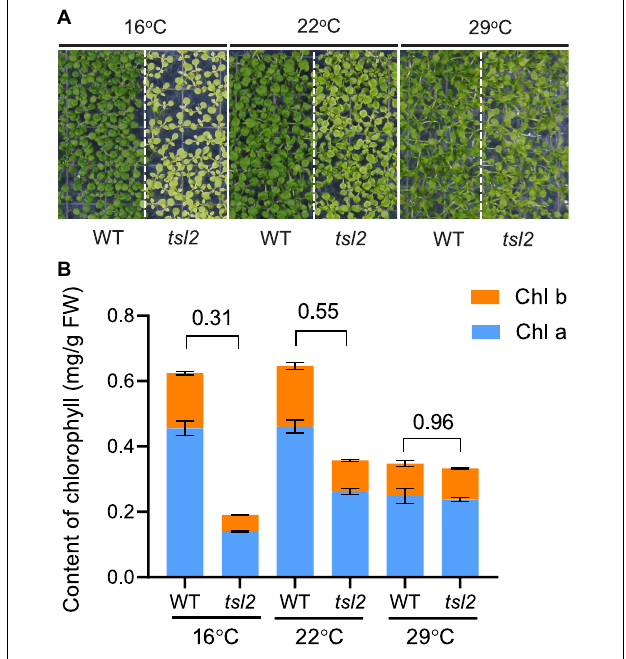
FIGURE 1 | The chloroplast development of tsl2 mutant is sensitive to cold temperatures. (A) Temperature-sensitive phenotypes of the tsl2 mutant plants. Wild-type (WT) and tsl2 mutant seedlings grown under normal growth temperature (22 ◦ C) for 4 days were kept at 22 ◦ C or transferred to 16 or 29 ◦ C for 10 days and then photographed. (B) Analysis of chlorophyll contents of plant leaves grown under different temperature conditions. The data represents the average of samples and the error bars indicate the standard error ( n =